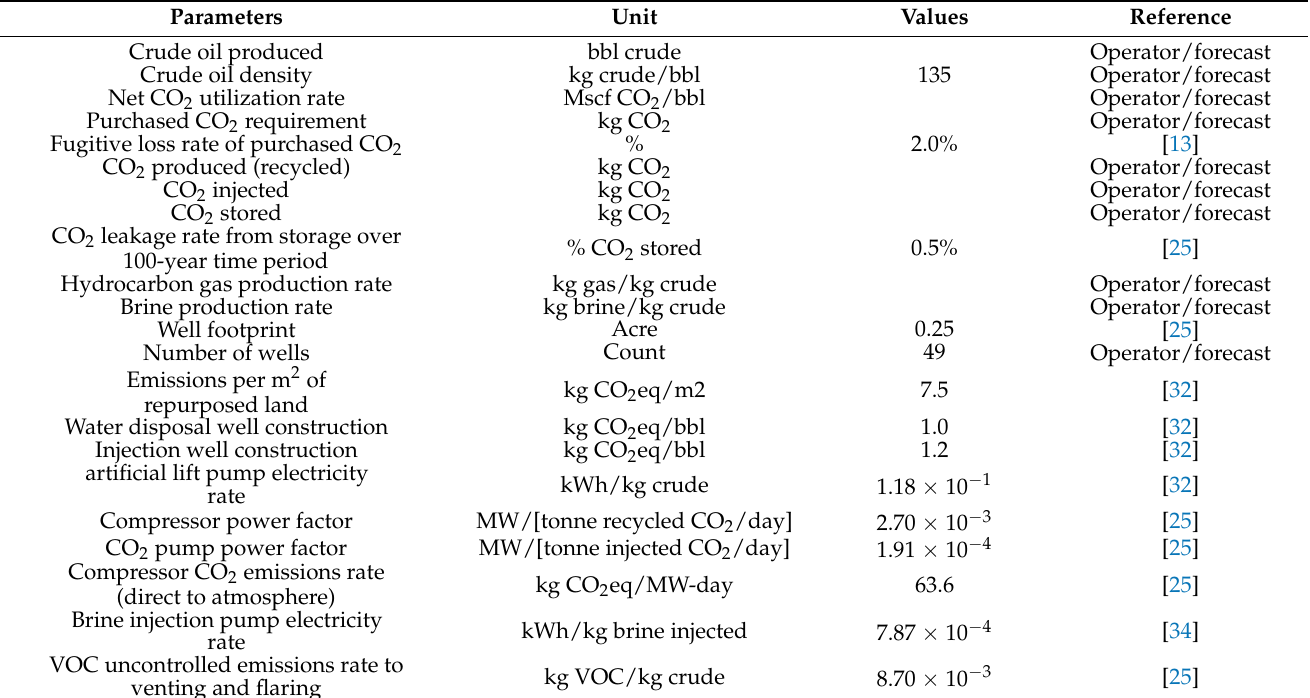
Table 3. Summary of parameter/factors and Input